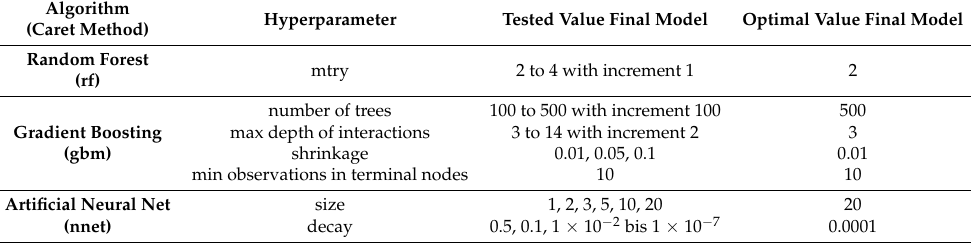
Table 2. Algorithms and tuning. Algorithm (Caret Method)